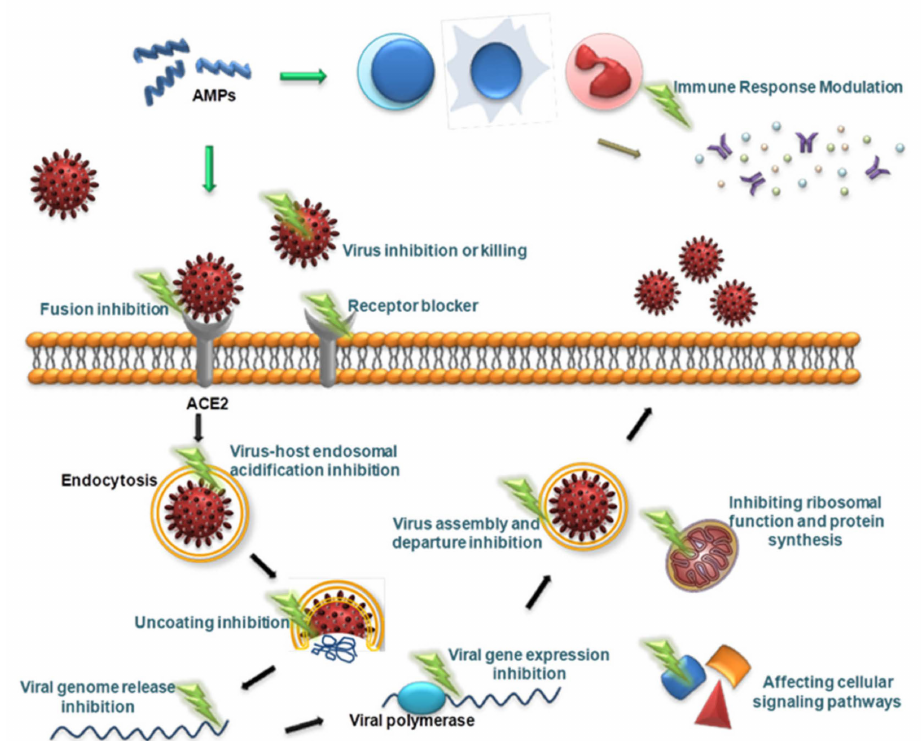
Figure 2. Schematic presentation of the antiviral mechanism of AVPs. AVPs can directly inhibit and kill viral particles, and can also exert antiviral effects at various stages of the viral replication cycle, including adsorption, penetration, uncoating, biosynthesis, assembly, and release. In addition, AVPs can inhibit viral infection by interfering with cellular signaling pathways and modulating the host immune